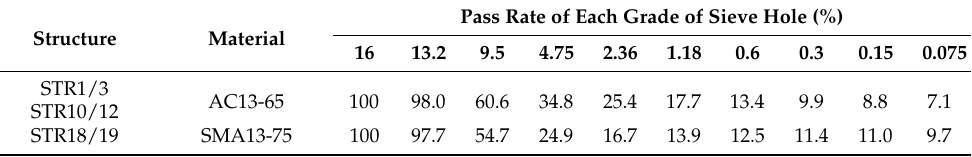
Table 3. Material gradation of the surface layer of each